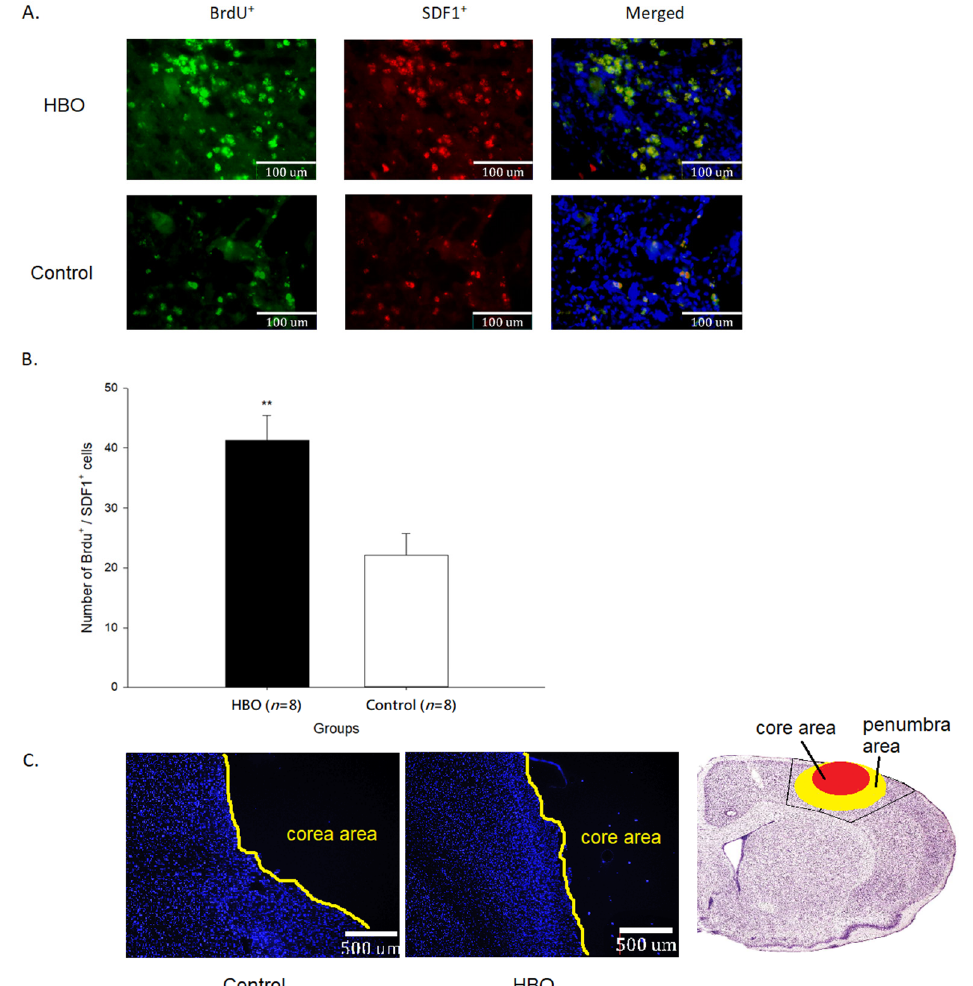
Figure 3. ( A ) The immunofluorescence imaging of BrdU + (green) and SDF1 + (red) cells in the penumbra area between groups (under 40 × objective lens). ( B ) The quantifications of BrdU + /SDF1 + cells in the penumbra area between groups. ( C ) Illustration of penumbra and core area boundaries (under 5× objective lens). Nuclei stained with DAPI (blue). **, p < 0.01. HBO: hyperbaric oxygen; SDF1: Stromal cell-derived factor 1.